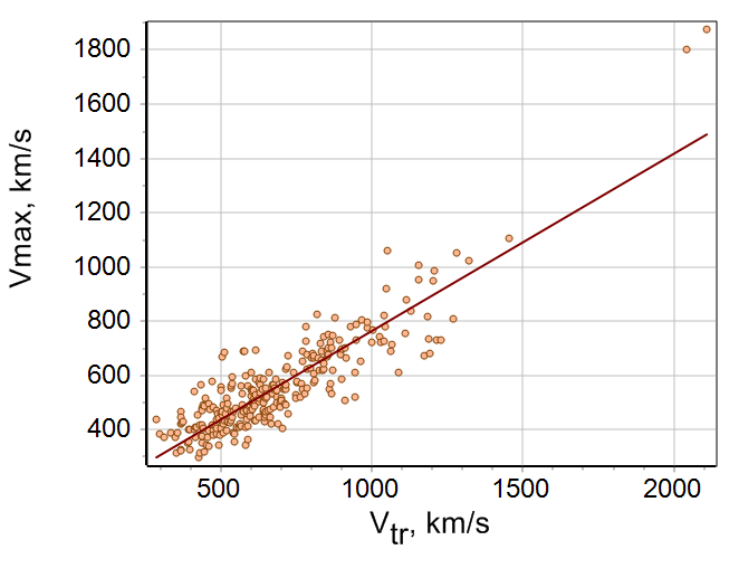
Figure 9. The relationship between the maximum and transit ICME speeds for 288 events under study.